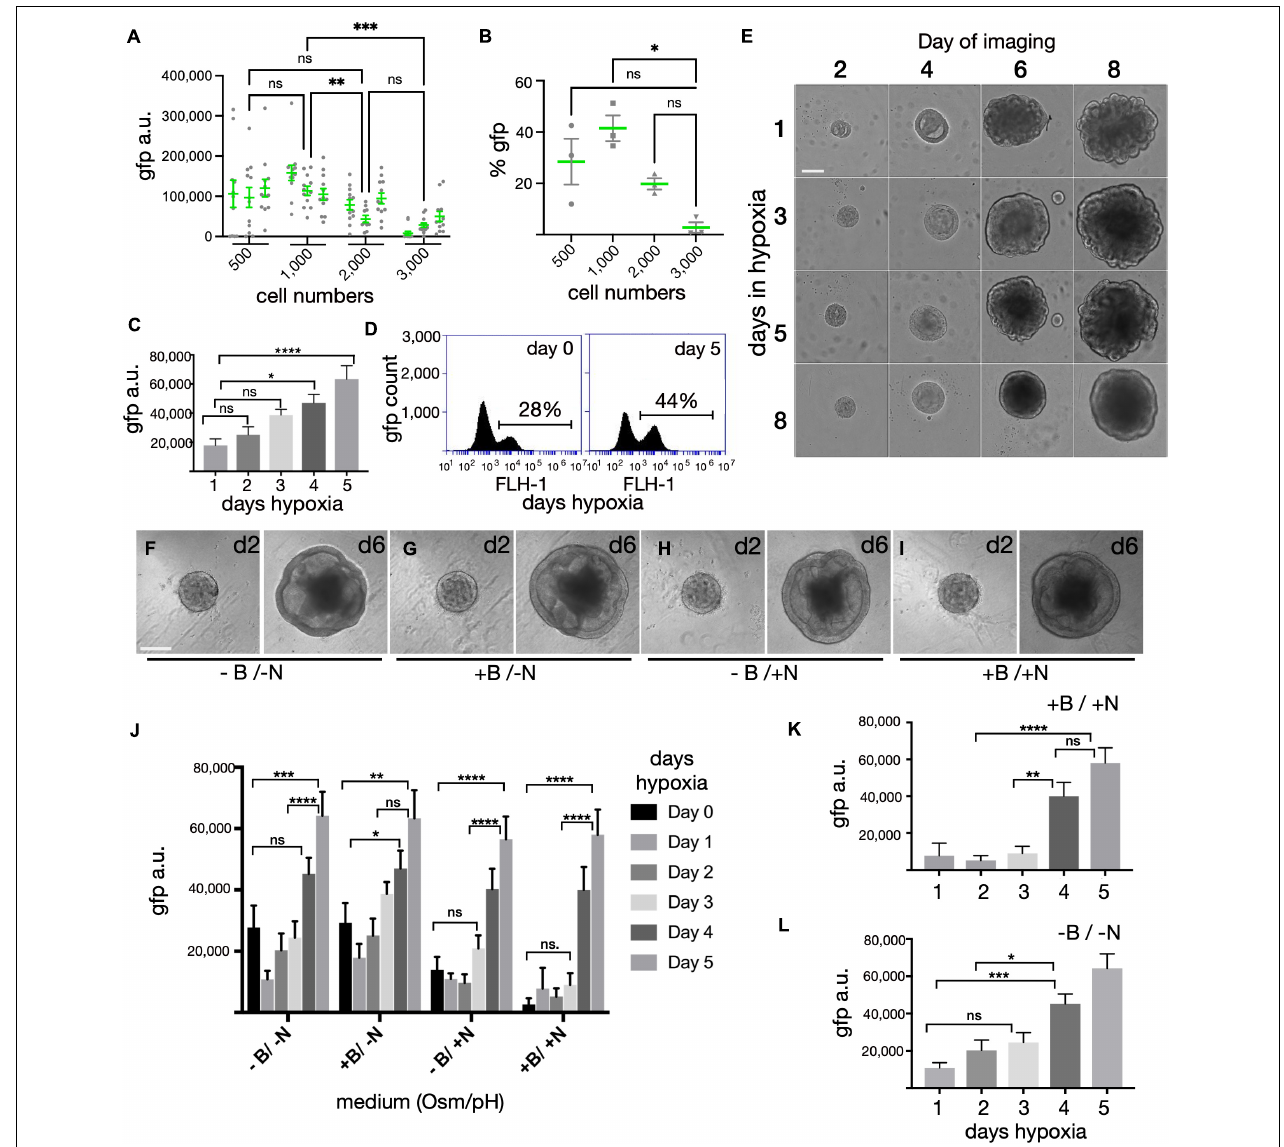
FIGURE 2 | Optimization of organoid size, hypoxia and cell culture medium on SIX6-GFP expression. (A) Forced aggregates created by seeding 500–3,000 iPSCs per well in a U-bottom 96-well plate, were measured for GFP fluorescence at D15 by high-content imaging ( n = 12/condition in triplicate; 144 total). (B) Organoids were pooled ( n = 12/condition), dissociated and analyzed in triplicate by flow cytometry at D15 to correlate trends observed in panel (A) . (C) Fluorescence intensity of forced aggregates at D15 grown from 1,000 cells under hypoxia for 1, 2, 3, 4, or 5 days ( n = 48 organoids; 240 total). (D) % of GFP cells by flow cytometry of organoids grown in hypoxia for 0 or 5 days ( n = 48 pooled samples/condition). (E) Morphological assessment of organoids initiated under hypoxia for 1, 3, 5, or 8-days and imaged at 2, 4, 6, and 8-days. (F–I) Morphological assessment of organoids at 2- and 6-days post-aggregation after growth in high or low osmolarity medium (+ N vs. –N) with or without bicarbonate (+ B vs. –B). (J) Fluorescence intensity measurements of organoids after 15 days following growth in hypoxia for 0–5 days in media with different osmolarity and pH ( n = 48 organoids; 1152 total). (K,L) The same values as in Panel (J) , but represented individually as N = sodium chloride (NaCl) and B = sodium bicarbonate (NaHCO3) ( n = 48; 480 total). gfp(a.u.) = gfp arbitrary unit; Statistical significance determined by one-way ANOVA; * = statistically significant ( p < 0.05), ** = statistically significant ( p < 0.01), *** = statistically significant ( p < 0.001), **** = statistically significant ( p < 0.0001), n.s. = not significant. Scale bars (E,F) = 150 µ